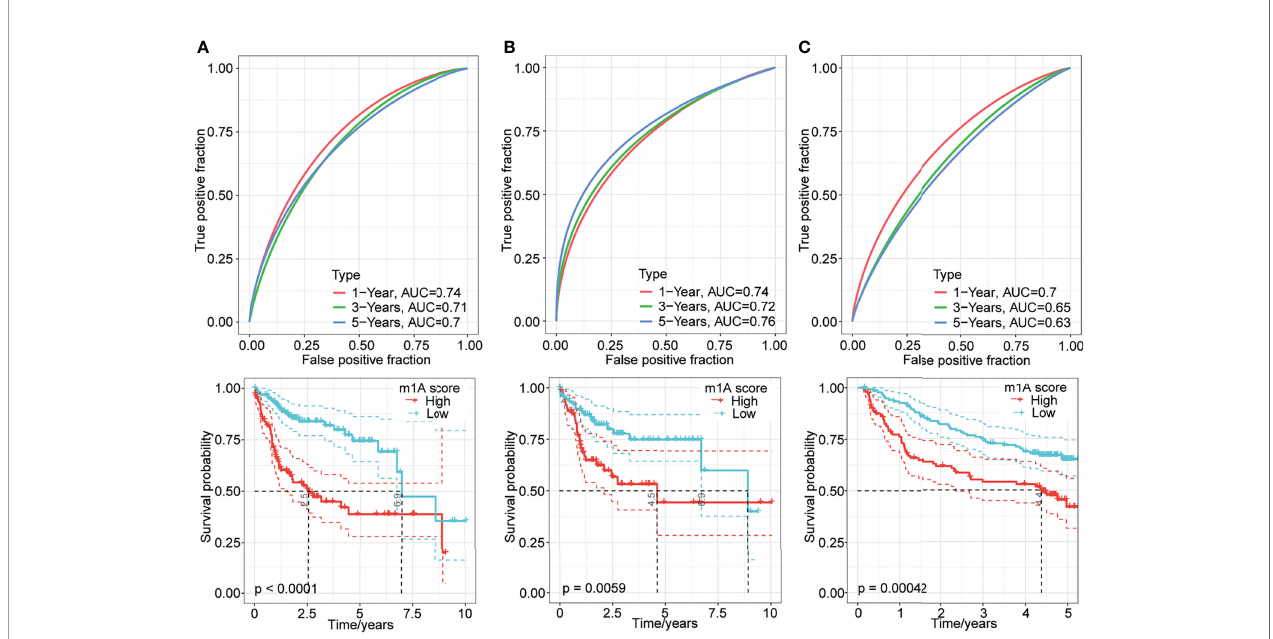
FIGURE 6 | Generation of the m1A-score model. (A – C) Time-dependent ROC analysis and Kaplan-Meier analysis of the fi ve-gene model in the TCGA-LIHC training dataset, entire TCGA-LIHC dataset, and GSE14520 dataset.